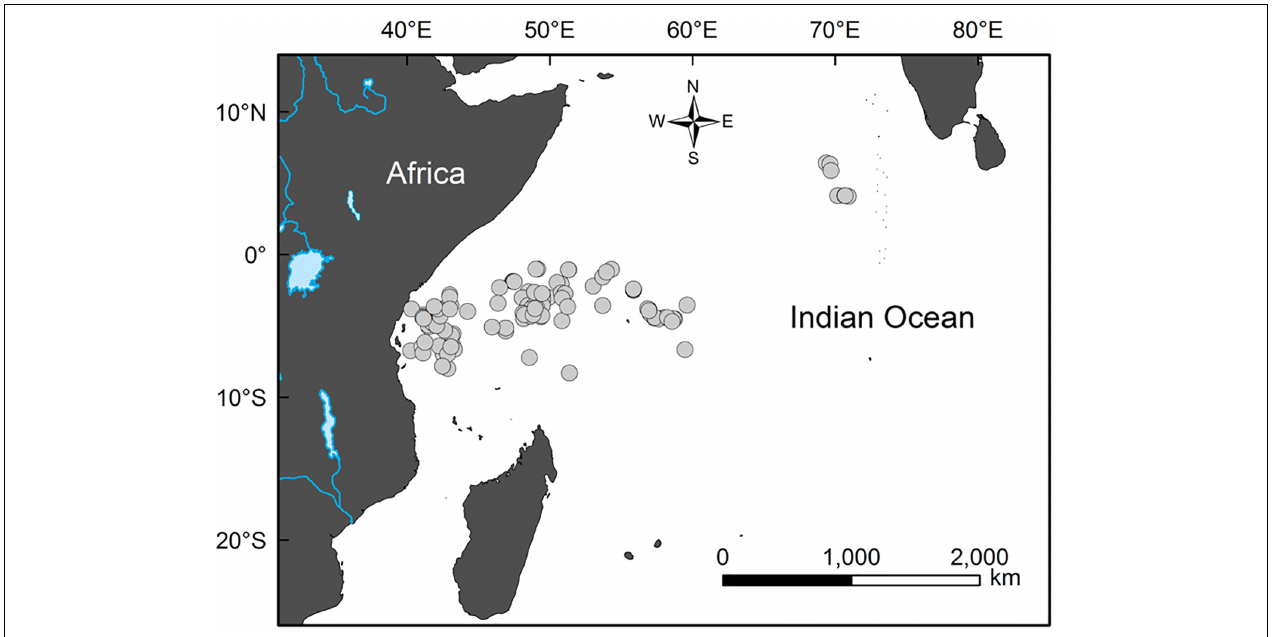
FIGURE 1 | Sampling sites (circles) of the bigeye tuna ( Thunnus obesus ) in the western Indian Ocean from April to December